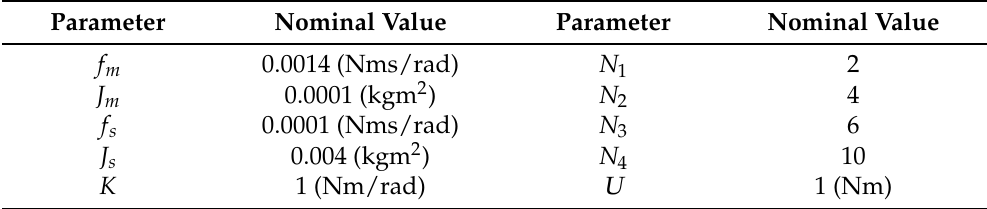
Table 3. Nominal parameter values.